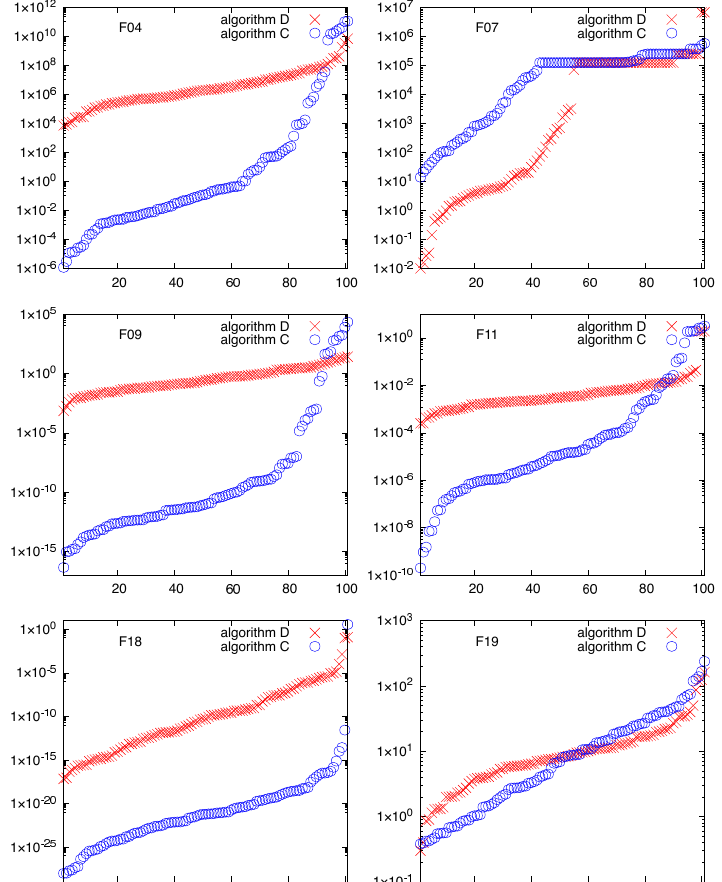
Figure 2. Solution quality for the sorted list of solutions obtained by algorithms C and D for F04, F07, F09, F11, F18 and F19 instances, respectively. The ordinate shows the quality of solution (also known as fitness or cost) and the abscissa the cardinal number of solutions in the sorted list − number 1 is the best obtained solution and number 101 is the worst